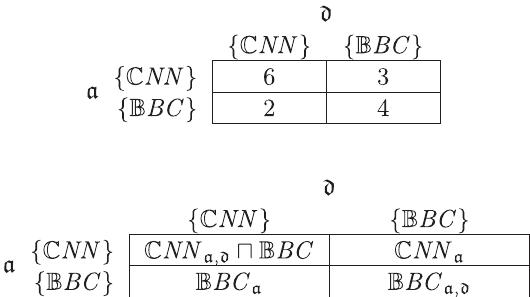
Fig. 1. Take U ¼ hK ; sites ð T woNews Þ ; sites ð T woNews Þ ; 1 ; 1 ; t i . The upper table corresponds to (cid:5) ðUÞ and the lower one to the values of the